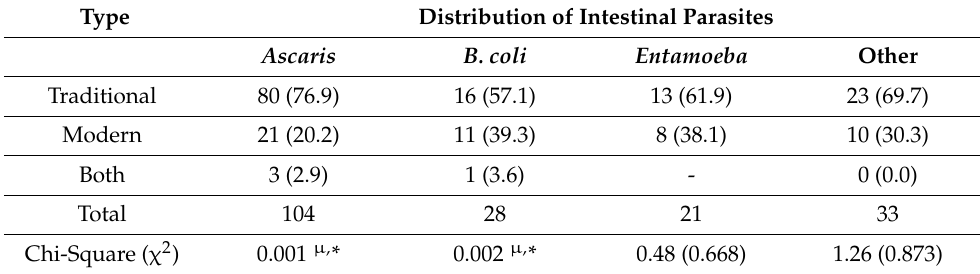
Table 6. Distribution of intestinal parasites by type of toilet